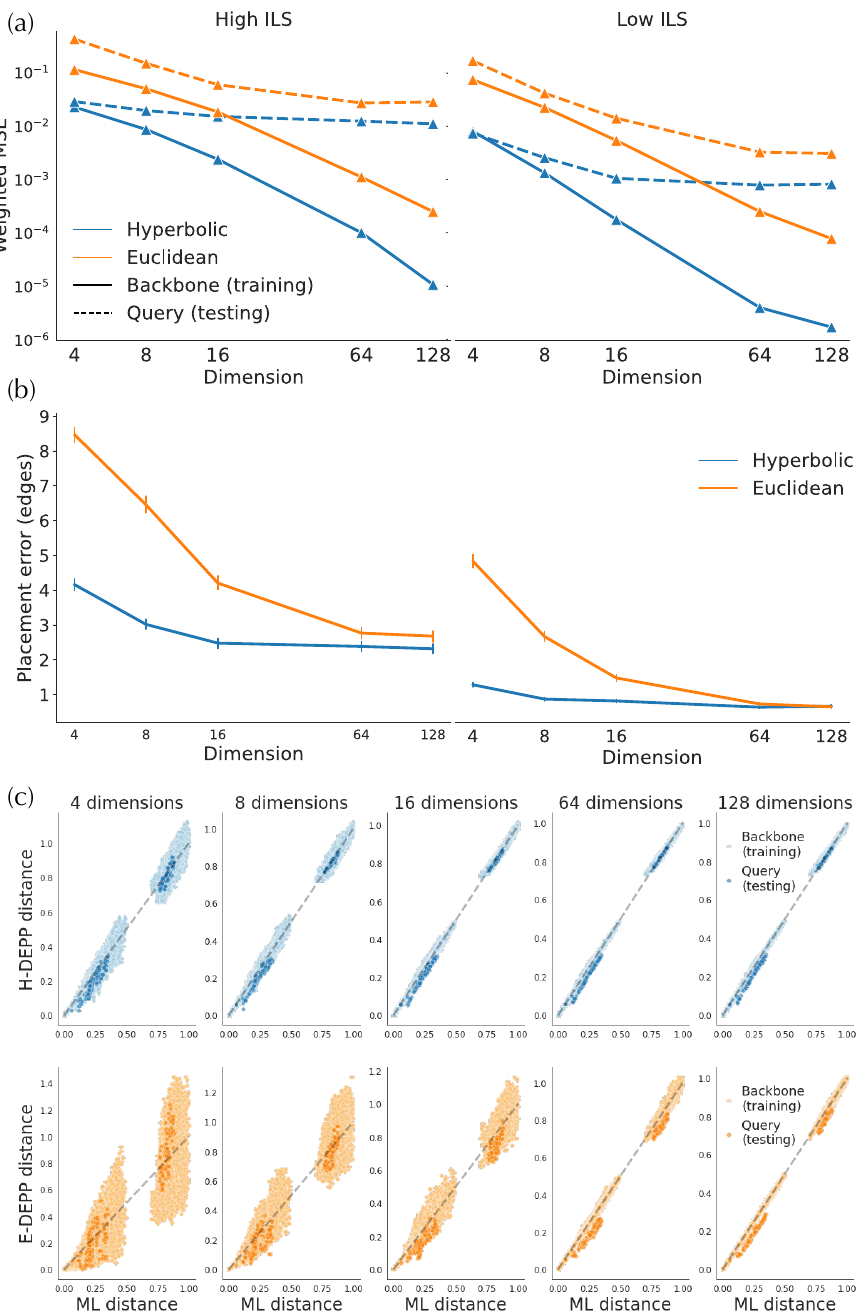
Figure 4. Hyperbolic and Euclidean embedding of simulated data. ( a ) Mean squared error (MSE) of embedding distances. ( b ) Placement error ( c ) True vs. estimated tree